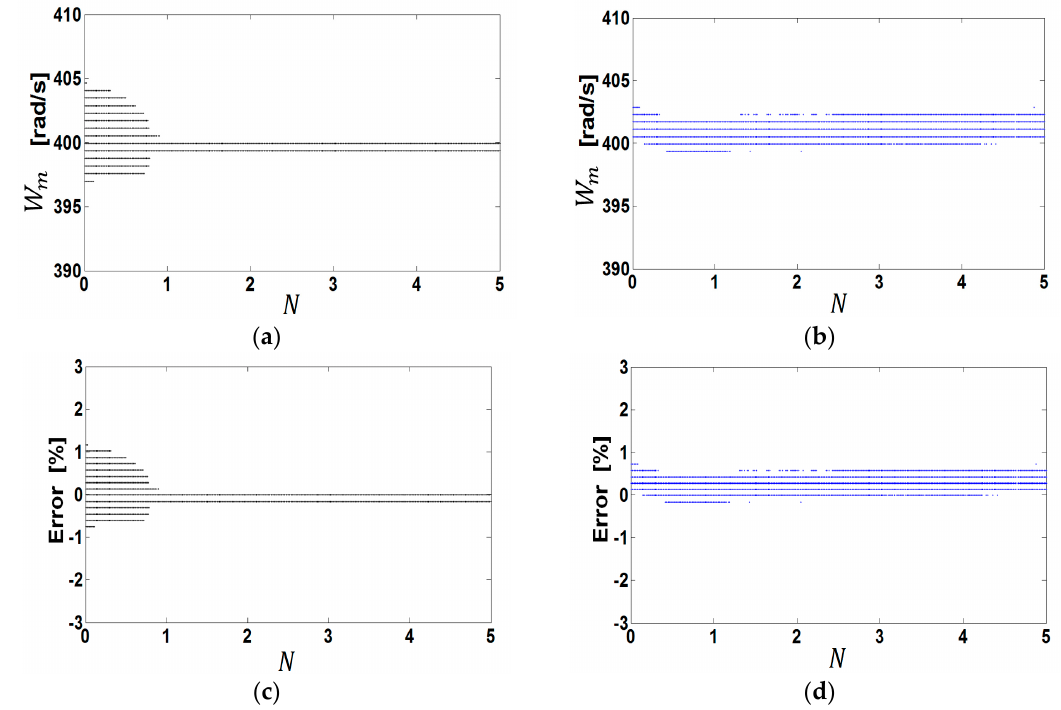
Figure 12. Bifurcation diagrams for the simulation and experimental test of the system with ZAD ( K S 3 = 35) and FPIC, changing the parameter N and maintaining fixed values of K S 1 = K S 2 = 2: ( a ) W m vs. N for the simulation test; ( b ) W m vs. N for the experimental test; ( c ) error vs. N for the simulation test; and ( d ) error vs. 𝑁 for the experimental test.